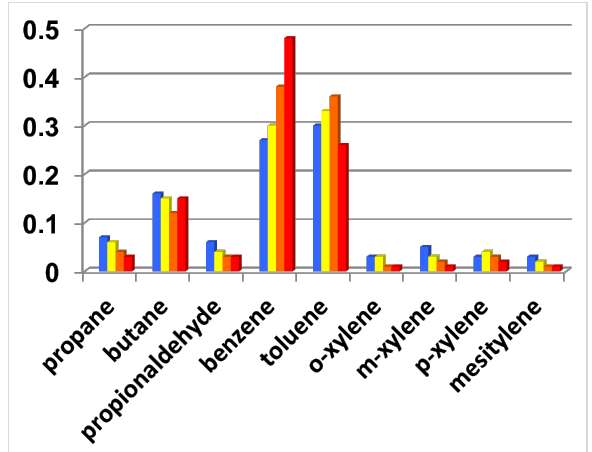
Figure 7: Product selectivities as a function of temperature: blue: 440 °C, yellow: 480 °C, orange: 500 °C, red: 520 °C. The experi- mental error from three repetitions is +/ − 0.03 for butane, benzene and toluene, and 0.01 for all other identified reaction products.